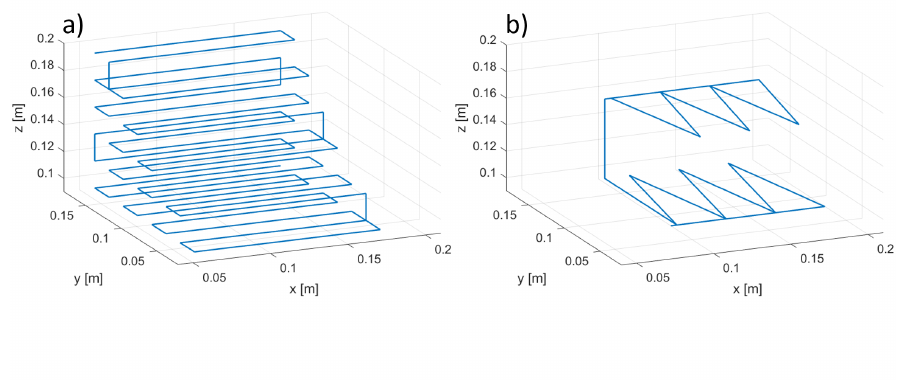
Figure 12. Calibration trajectory ( a ) and measurement trajectory ( b